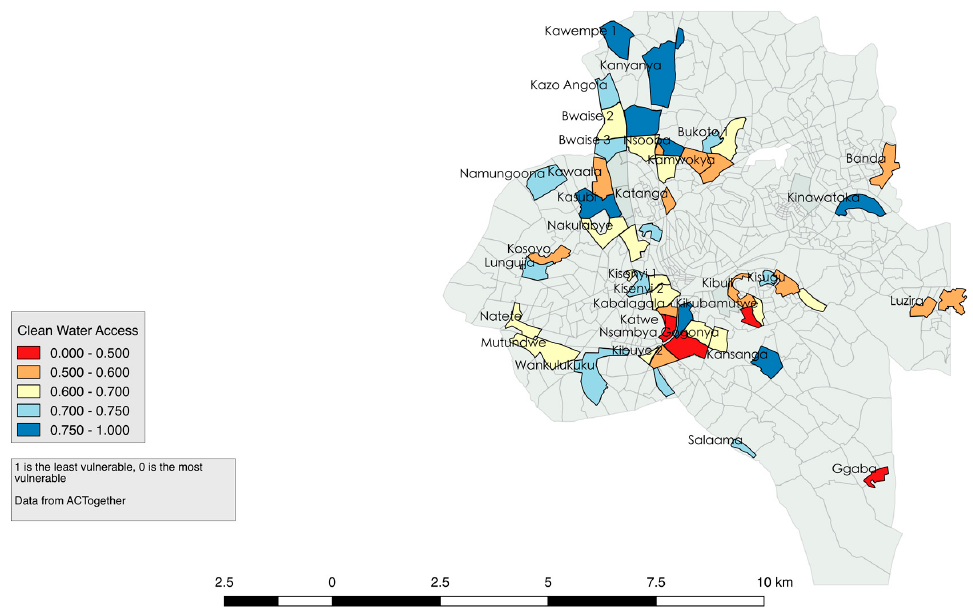
Figure 3. Clean Water Vulnerability; Created with QGIS using variables in Table 1. 48 out of 57 slum communities have a water vulnerability score of under 0.75 (1 is least vulnerable and 0 is most vulnerable). The geographical units portrayed are Ugandan village boundaries.